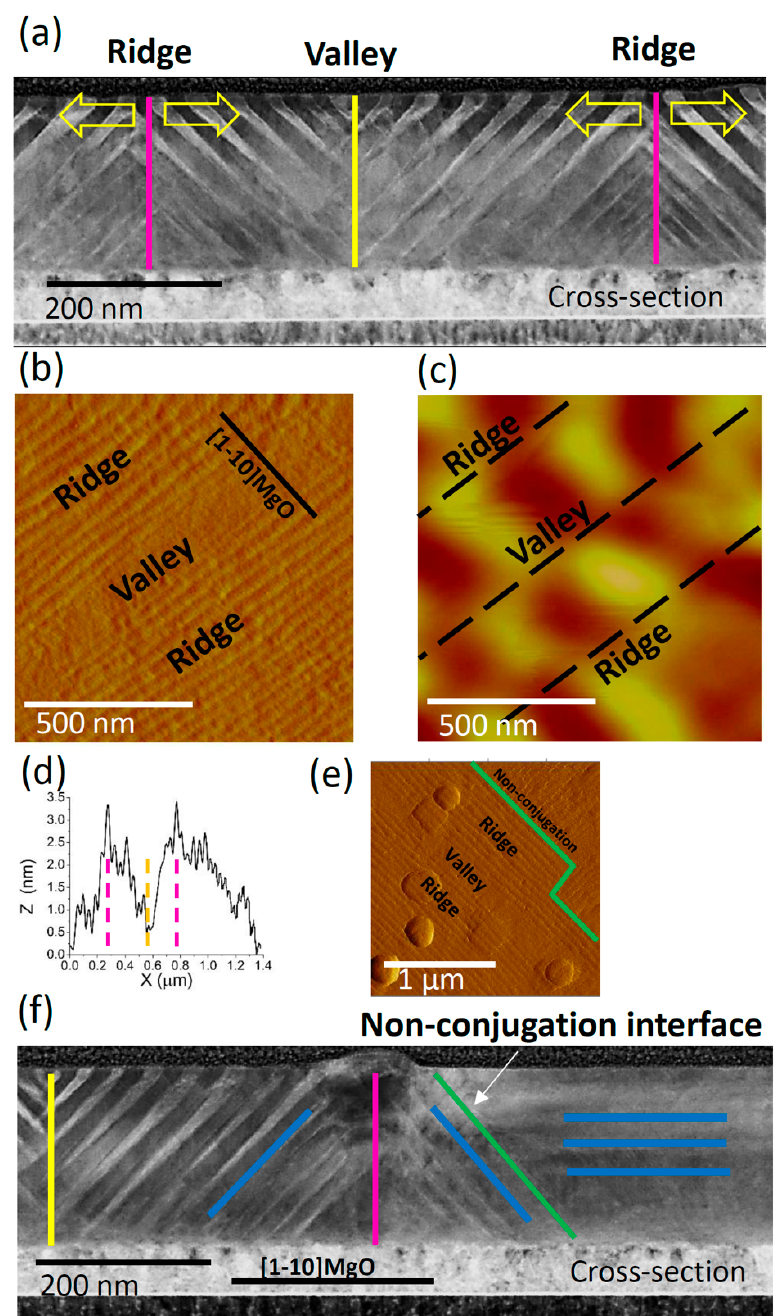
Figure 4. (a) HAADF image of sample #2 showing the ridges and valleys created by the conjugation interfaces (pink and yellow lines); ( b , c ) AFM/MFM images of sample #2 at RT showing the conjugation interfaces in plan - view (b) and the related disconnections in the magnetic domains (c); ( d ) height profile (Z) of the topography (b) taken along the [1+10] direction of MgO (X), showing the position of the two ridges and the valley; ( e ) topography image illustrating the conjugation and non - conjugation interfaces (green lines) in plan - view; ( f ) HAADF image of sample #2 showing the non - conjugation interface (green line) in cross section view, the geometry of the twins (blue lines) and the conjugation interfaces (pink and yellow).